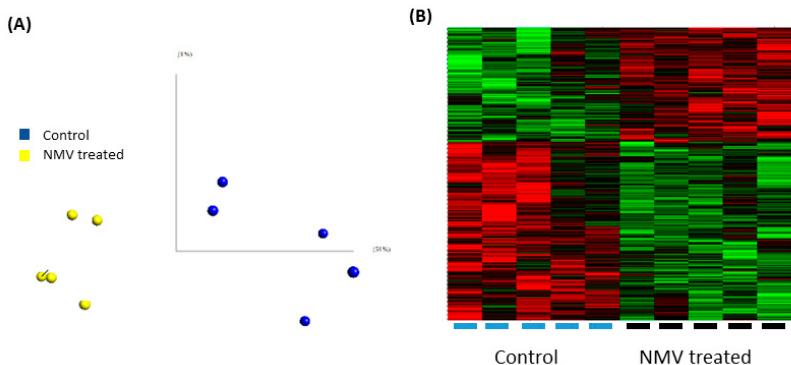
Figure 4. Internalization of NMV significantly impacts the transcriptome of hCMEC/D3. ( A ) Principal component analysis of microarray data. ( B ) Heat map depicting up-regulated (red) and down-regulated (green) gene expression changes (FC ≥ 1.2, p ≤ 0.05), 932 genes were significantly differentially expressed (363 up-regulated genes and 569 down-regulated genes). Blue bars represent untreated BMEC samples while the black bars represent BMEC treated with NMV.